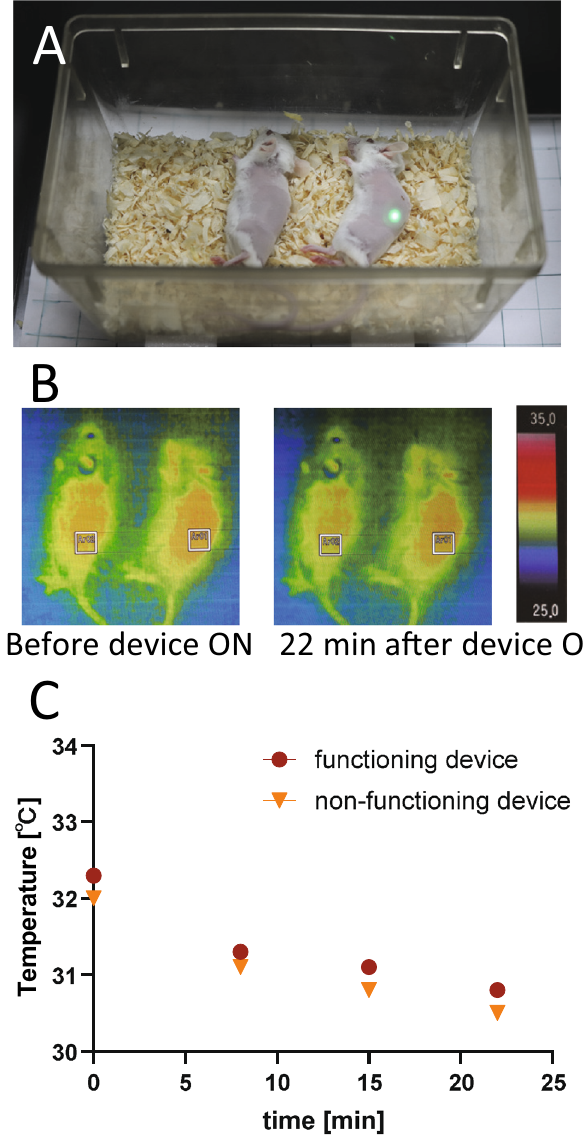
Figure 7. Confirmation that no heat was generated by the wirelessly powered implantable LED device. (A) Mice under anesthesia in a cage placed on the antenna board. The mouse on the right was implanted with a functioning device, while the mouse on the left was implanted with a nonfunctioning device in which a current did not flow through the receiver coil for the radio feeding. (B) Images of thermography. Square frames (white color line) indicate the location of the implanted device. (C) Temperature change in the skin covering the